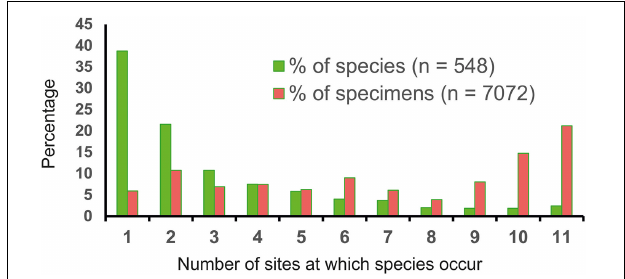
FIGURE 8 | The percentage abundance of species (total = 548) represented by complete tests and specimens (total = 7072) occurring at different numbers of sites (from a single site on the left of the x axis to all 11 sites on the right) within the UK-1 and OMS areas in the eastern CCZ. On the left-hand side, 60.2% of species are confined to 1 or 2 sites but these represent only 16.6% of specimens (i.e., species confined to 1 or 2 sites tend to be rare). In contrast, only 4.2% of species occur at 10 or 11 sites, but these represent 35.9% of specimens (i.e., widely-distributed species tend to be abundant). The relatively high percentage (10.7%) of specimens occurring at 2 sites (second point on x axis) reflects the high abundance ( n = 296) of a single species. If this is removed, then the contribution of species confined to 1 or 2 sites decreases from 16.6% to 13.0% of specimens and that of species occurring at 10 or 11 sites increases 35.9 to 37.5%. Based on data from Goineau and Gooday